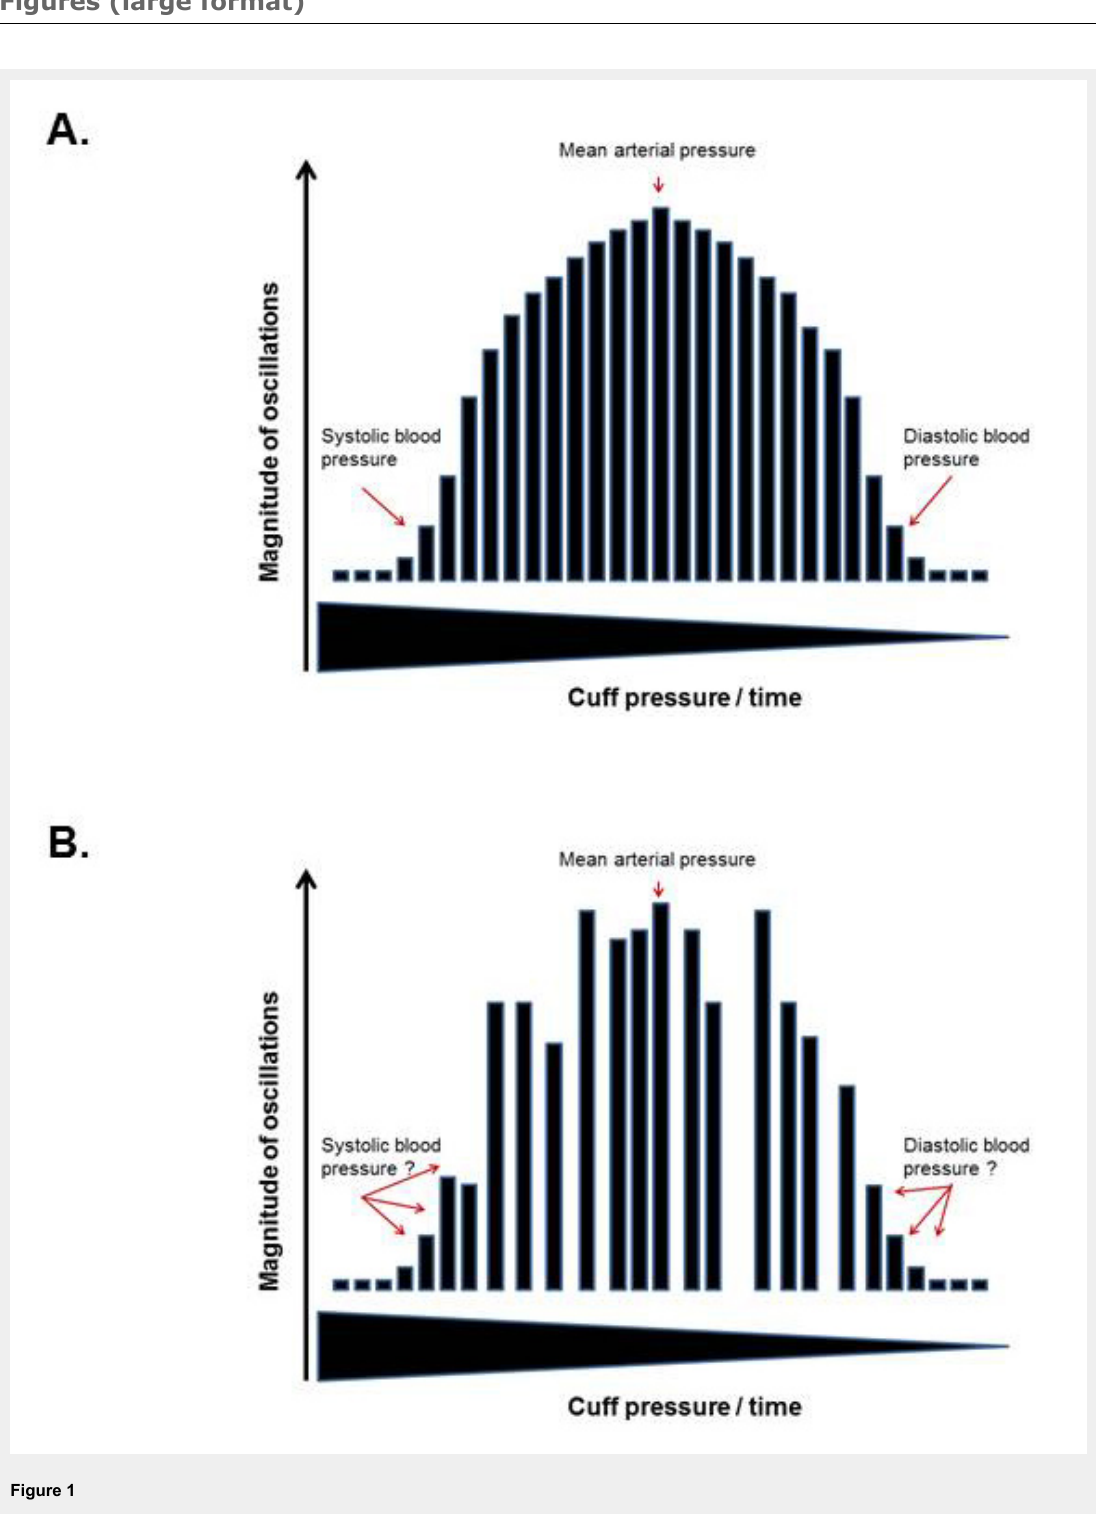
Oscillometric blood pressure measurement (technical principle). A Decreasing cuff pressure allows continuous increase of blood flow with consecutive increase in oscillation amplitude. When reaching mean arterial BP, amplitude of oscillations decreases. Estimation of systolic and diastolic BP depends on algorithms designed by the manufacturer of the device. B Arrhythmia leads to changing ventricular filling with consecutively alternating pulse pressure and alternating magnitude of oscillations, rendering determination of systolic and diastolic BP difficult at the least, if not